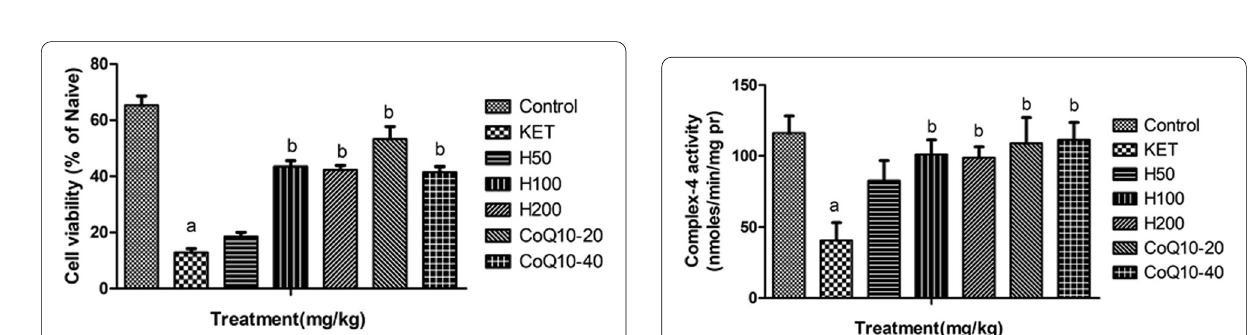
Fig. 18 Effect of hesperidin and Coenzyme Q10 on complex IV enzyme activity in the hippocampus region of the brain. Data were analyzed by one-way ANOVA followed by Tukey’s post hoc analysis. All values were expressed as Mean SEM. a p < 0.05 as compared ± to naive, b p < 0.05 as compared to ketamine. KET, Ketamine; H, Hesperidin; CoQ10, Coenzyme